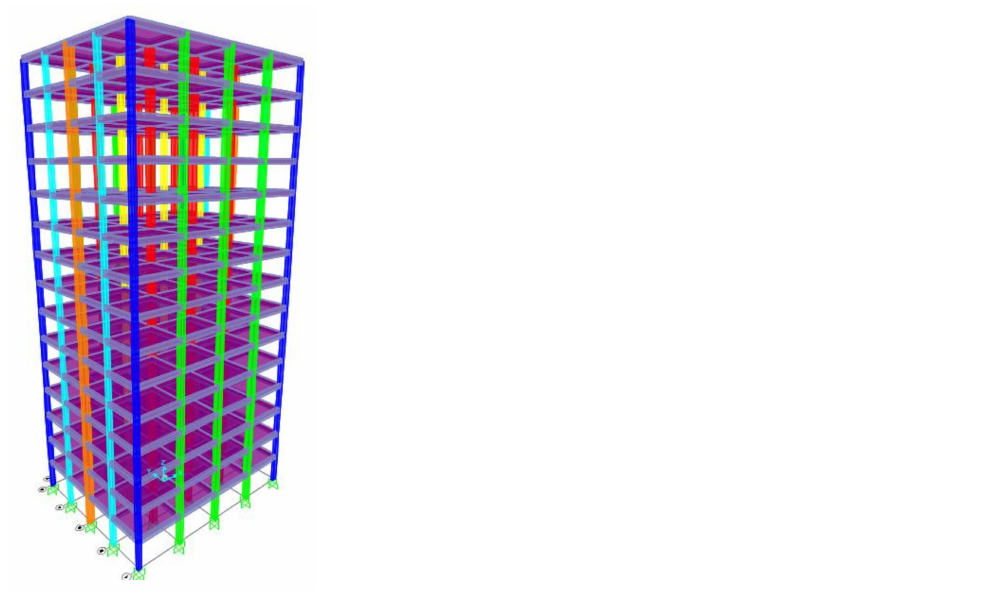
Figure 9. The FE model of the multi-story residential building used in the analyses.